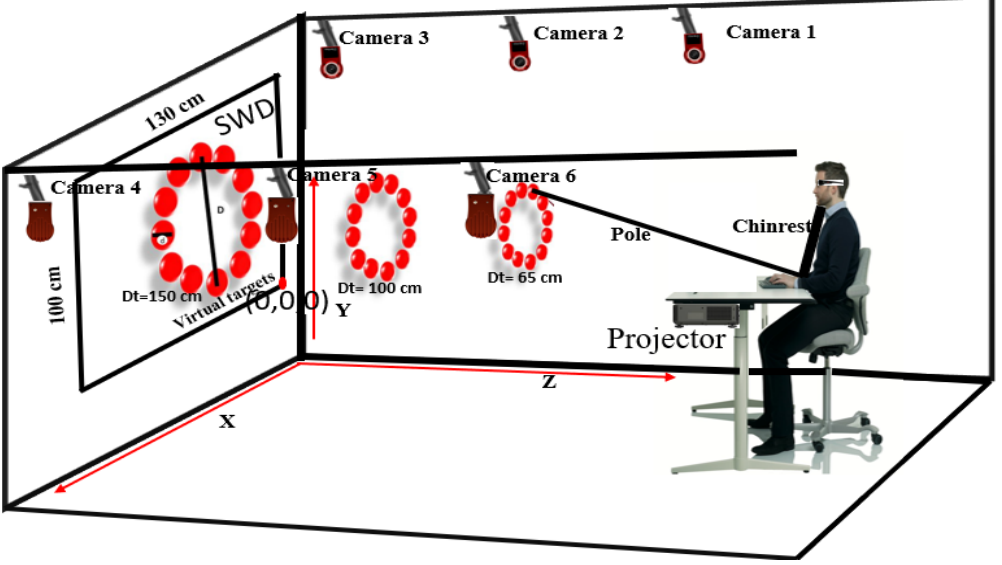
Figure 1. Illustration of experimental layout for both stereoscopic widescreen display (SWD) and head-mounted display (HMD), relative locations of the ViewSonic 3D projector, and target